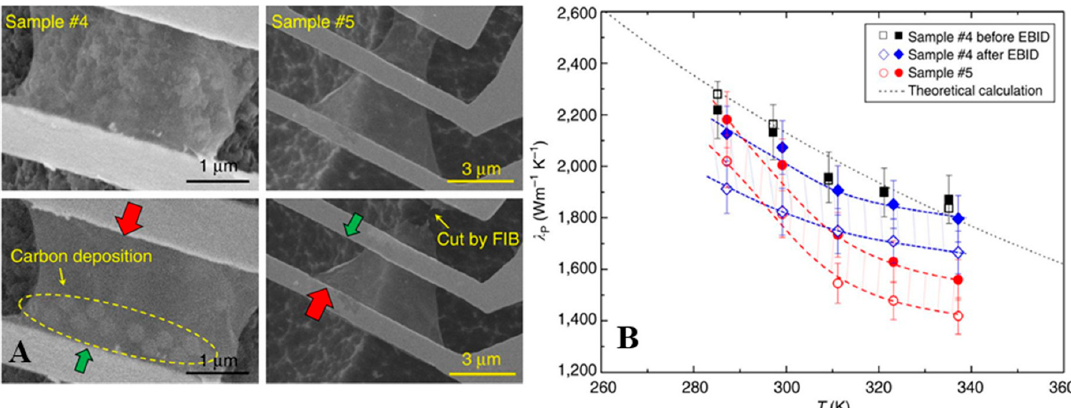
Figure 7. ( A ) SEM images of Sample 4 (before and after nanoparticle deposition by EBID) and sample #5 with a tapered width. ( B ) The comparison between measured thermal conductivities in different heat flux directions as a function of temperature. Reprinted with permission from Springer Nature Publishing Group.